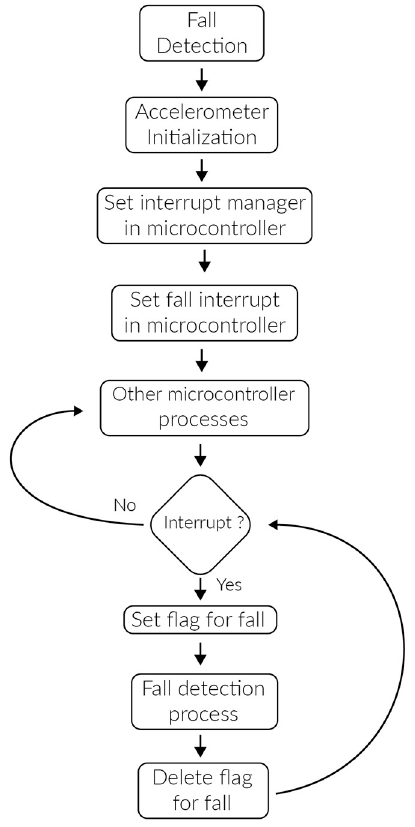
Figure 15. Fall detection process.